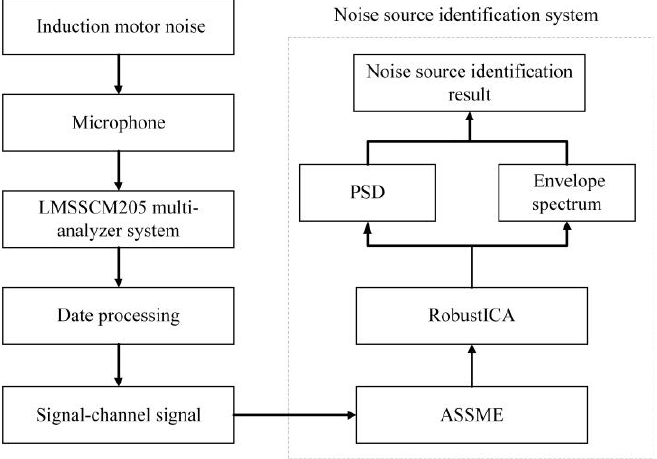
Figure 10. The flow chart of noise source identification.